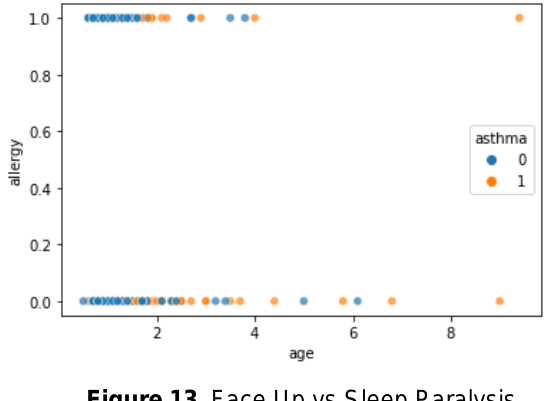
Figure 13. Face Up vs Sleep Paralysis